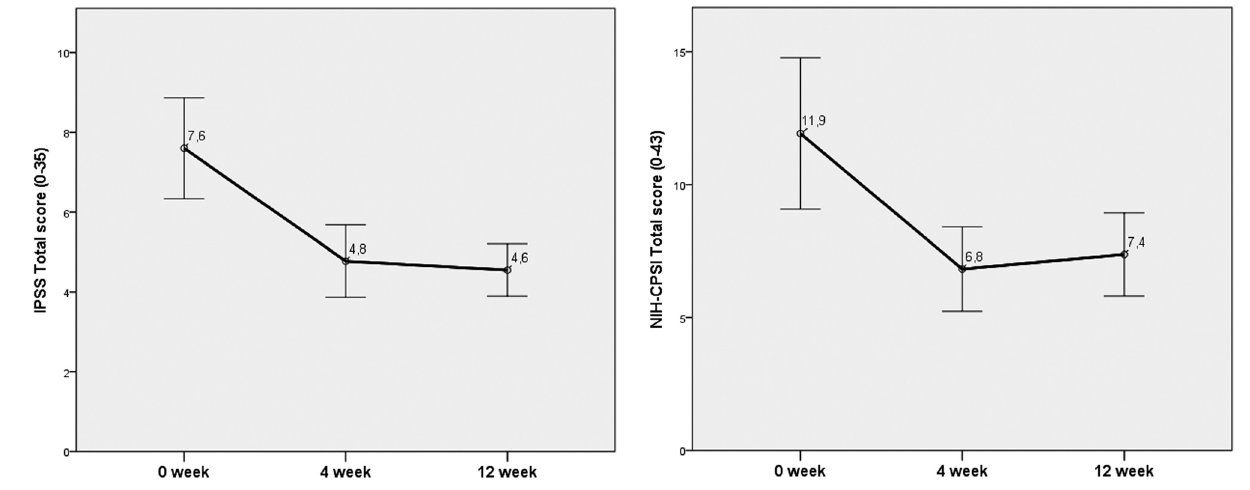
Figure 5: Changes in the NIH - CPSI.